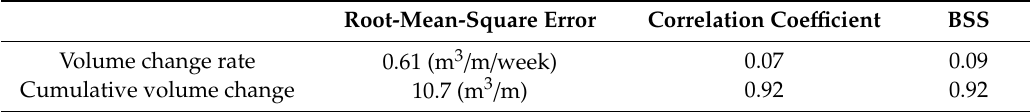
Figure 15. Time series of the measured and simulated cumulative volume changes in the calibration process. Table 1. The root-mean-square error, the correlation coe ffi cient, and BSS for the weekly averaged volume change rate and the cumulative volume change in the calibration process.